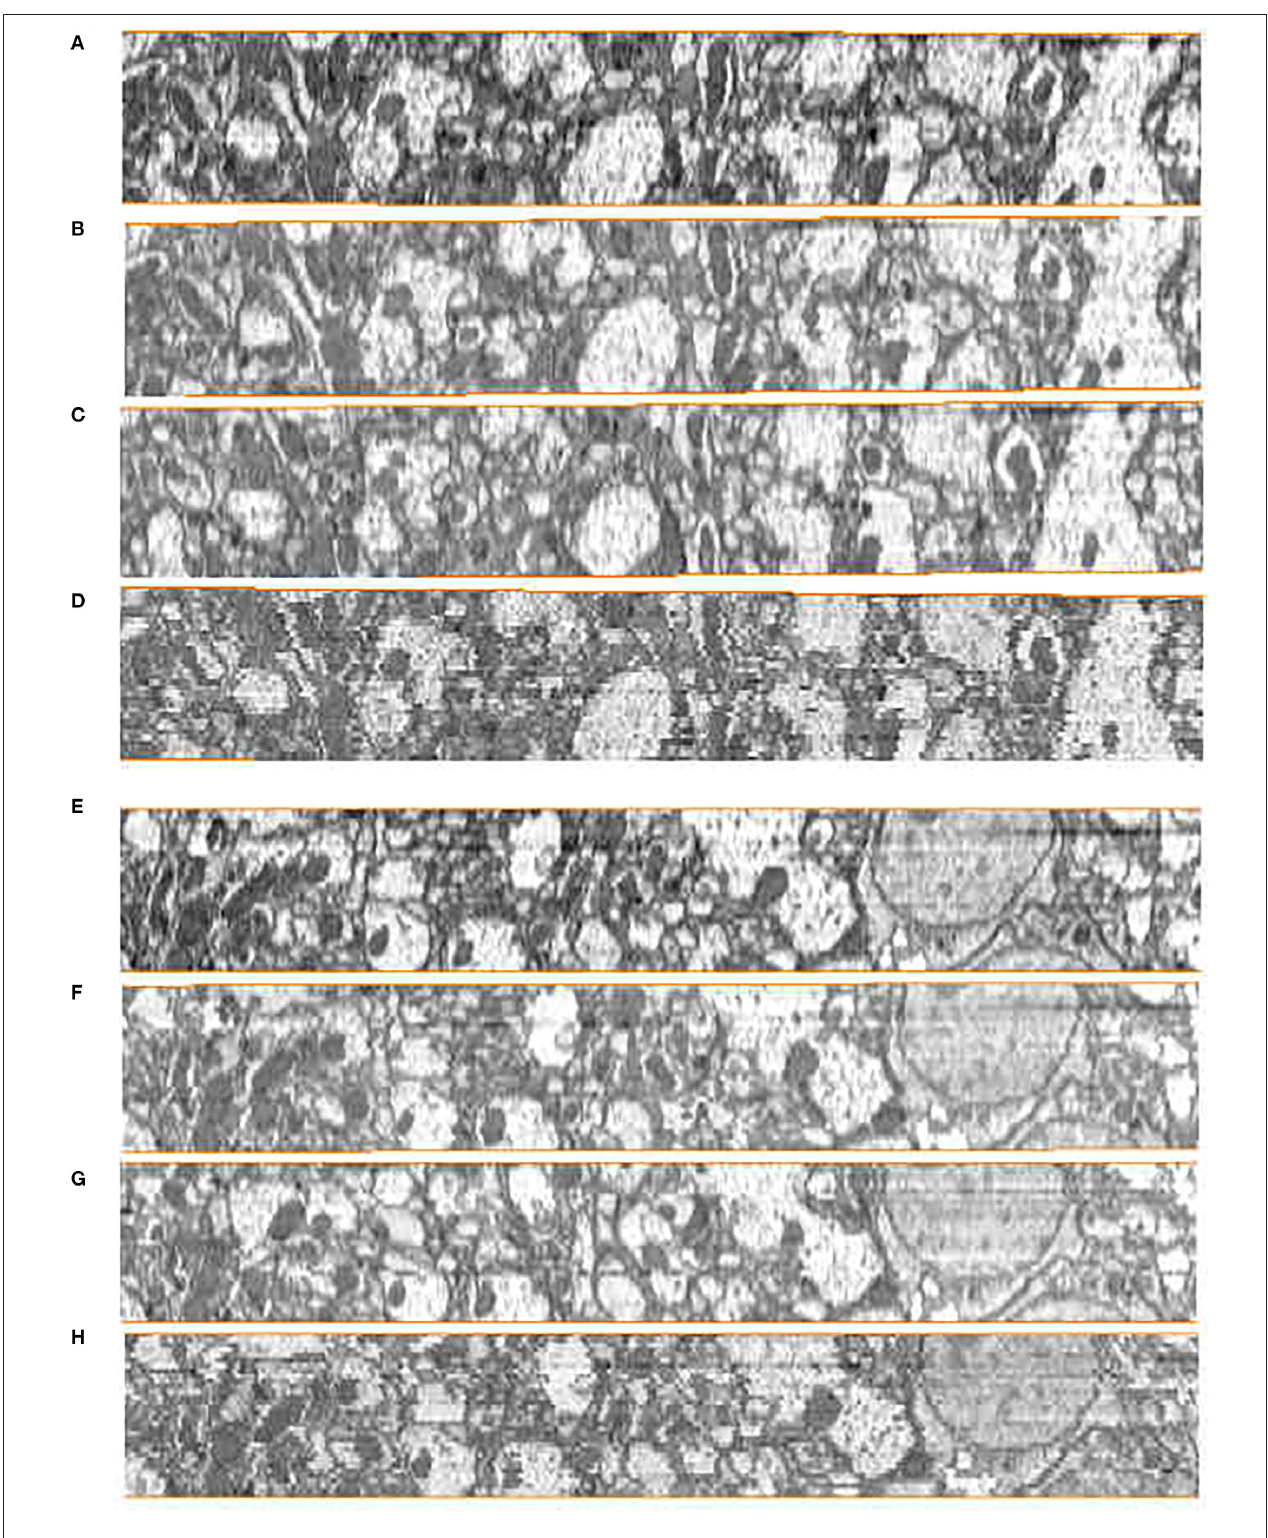
FIGURE 7 | Registration results in the yz plane on the Drosophila FIB-SEM (DFS) dataset. (A,E) Ground truth. (B,F) Our results. (C,G) Wang CW results. (D,H) Elastic results.